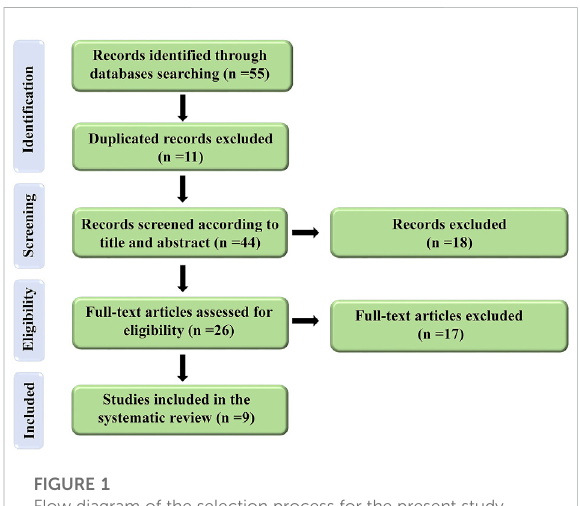
FIGURE 1 Flow diagram of the selection process for the present